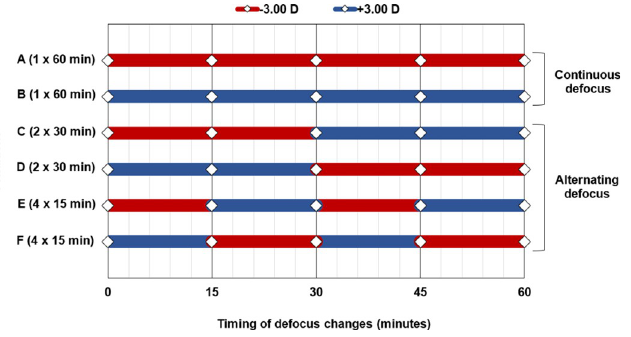
Fig 1. Illustration of the type of defocus imposed on the right eye for each measurement day. On six separate measurement days, the right eye was exposed to one of the following conditions (in a randomized order): (A) continuous hyperopic (-3 D) defocus (1 x 60 minutes), (B) continuous myopic (+3 D) defocus (1 x 60 minutes), (C) alternating low frequency cycles of hyperopic then myopic defocus (2 x 30 minutes), (D) alternating low frequency cycles of myopic then hyperopic defocus (2 x 30 minutes), (E) alternating high frequency cycles of hyperopic then myopic defocus (4 x 15 minutes), and (F) alternating high frequency cycles of myopic then hyperopic defocus (4 x 15 minutes).